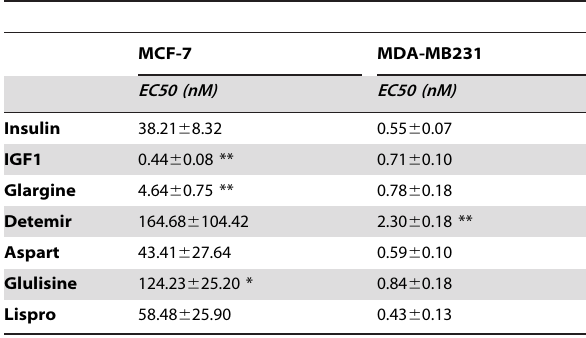
Table 2. EC50s of insulin, insulin analogues and IGF1 for PIP 3 production in MCF-7 and MDA-MB231